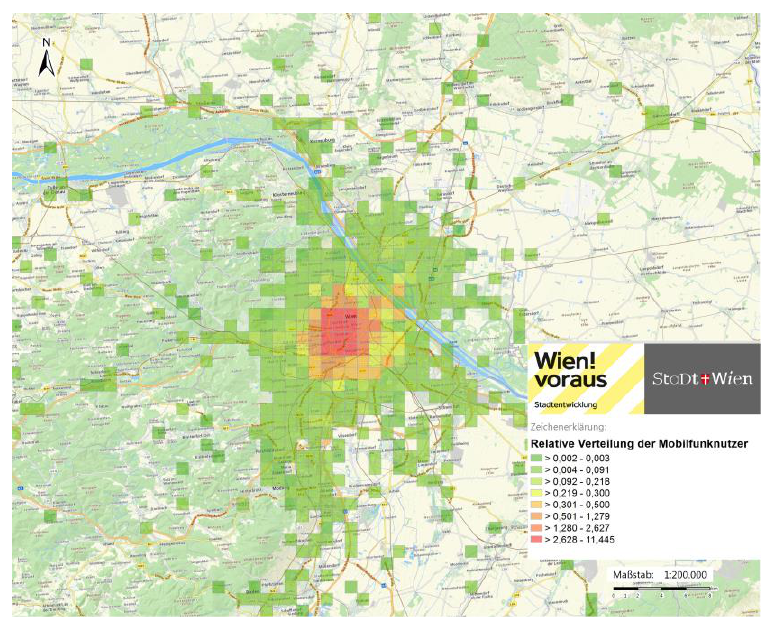
Figure 12. Mobility pattern of residents living in inner districts of the City of Vienna (German labels used to support local language).